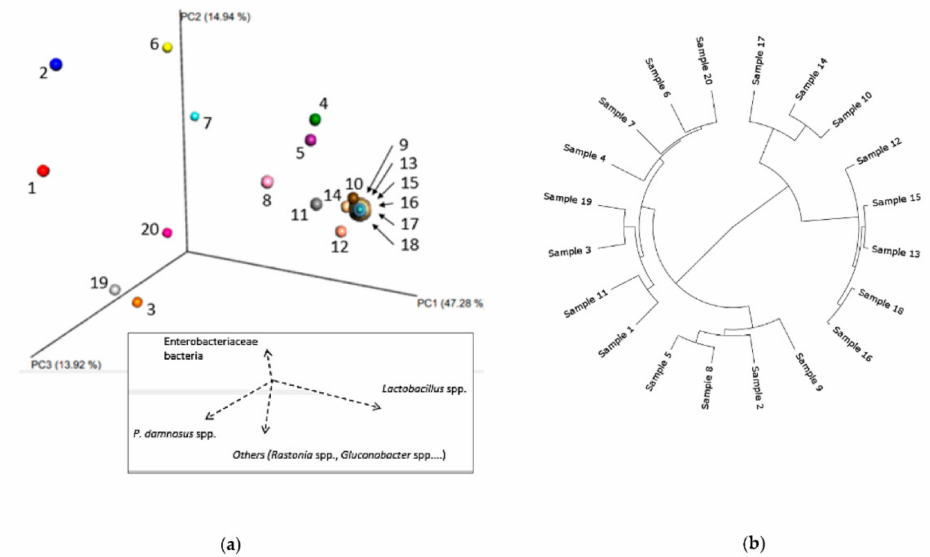
Figure 3. Sample similarity based on bacterial composition. ( a ) PCoA tridimensional plot created using the matrix of pairwise distances between samples calculated by the Bray–Curtis dissimilarity using genera found in the microbial composition. 3D images, schematic representation, and visualization were generated using the EMPeror tool. Below the PCoA plot is a schematic representation based on the sample composition, in which arrows show different directions for locating the samples on the graph according to the presence and concentration of Enterobacteriaceae bacteria, Lactobacillus spp., P. damnosus , and other bacteria such as Ralstonia spp. and Gluconobacter spp. ( b ) Phylogenetic tree showing clustering of the samples by similarity of their taxonomic composition, calculated by the Bray–Curtis dissimilarity at the ASV level using Ward’s